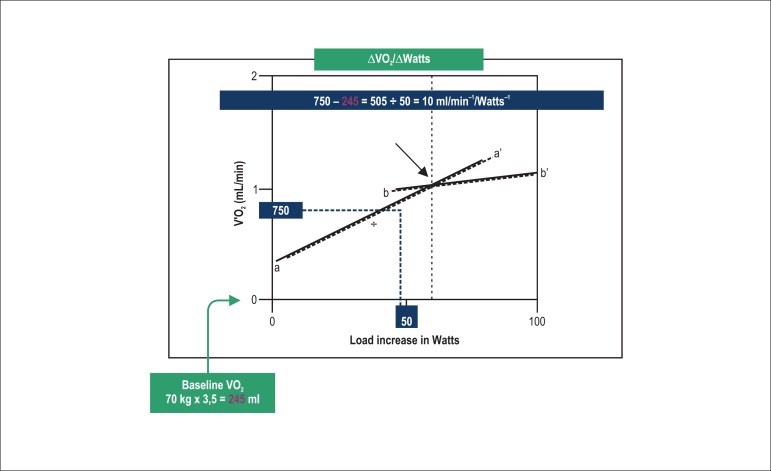
The ΔVO2 /ΔWR relationship around
10mL.min.Watts suddenly reduces, despite the exercise intensity
increase. This loss of linear relationship could indicate the
presence of myocardial ischemia by use of CPET performed on a cycle
ergometer (modified from reference 52).